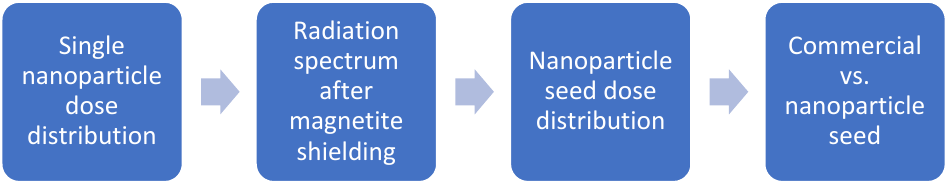
Figure 2. Overview of the simulations performed to characterize the nanoparticle seeds.